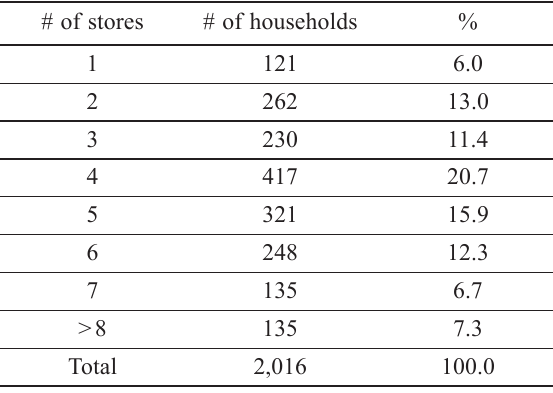
and the Balearic Islands Tradi- Discount Super- House- tional & Self- Hyper- Stores mar- holds retail Service markets kets stores Stores